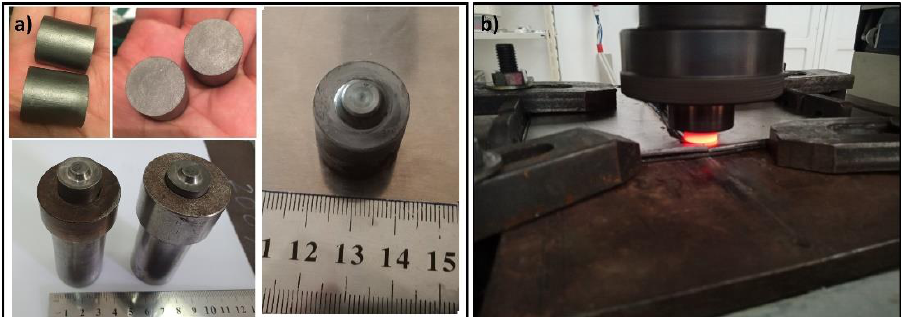
Figure 16. The manufactured cylindrical parts from the WC-based composites with 5 wt% Ni and 2.5 wt% Y 2 O 3 for the FSW tool applications. ( a ) Images of the parts after consolidation, grinding for the required geometries and insertion in the tool steel holder. ( b ) The FSW tool during the welding of the Ni base alloy.